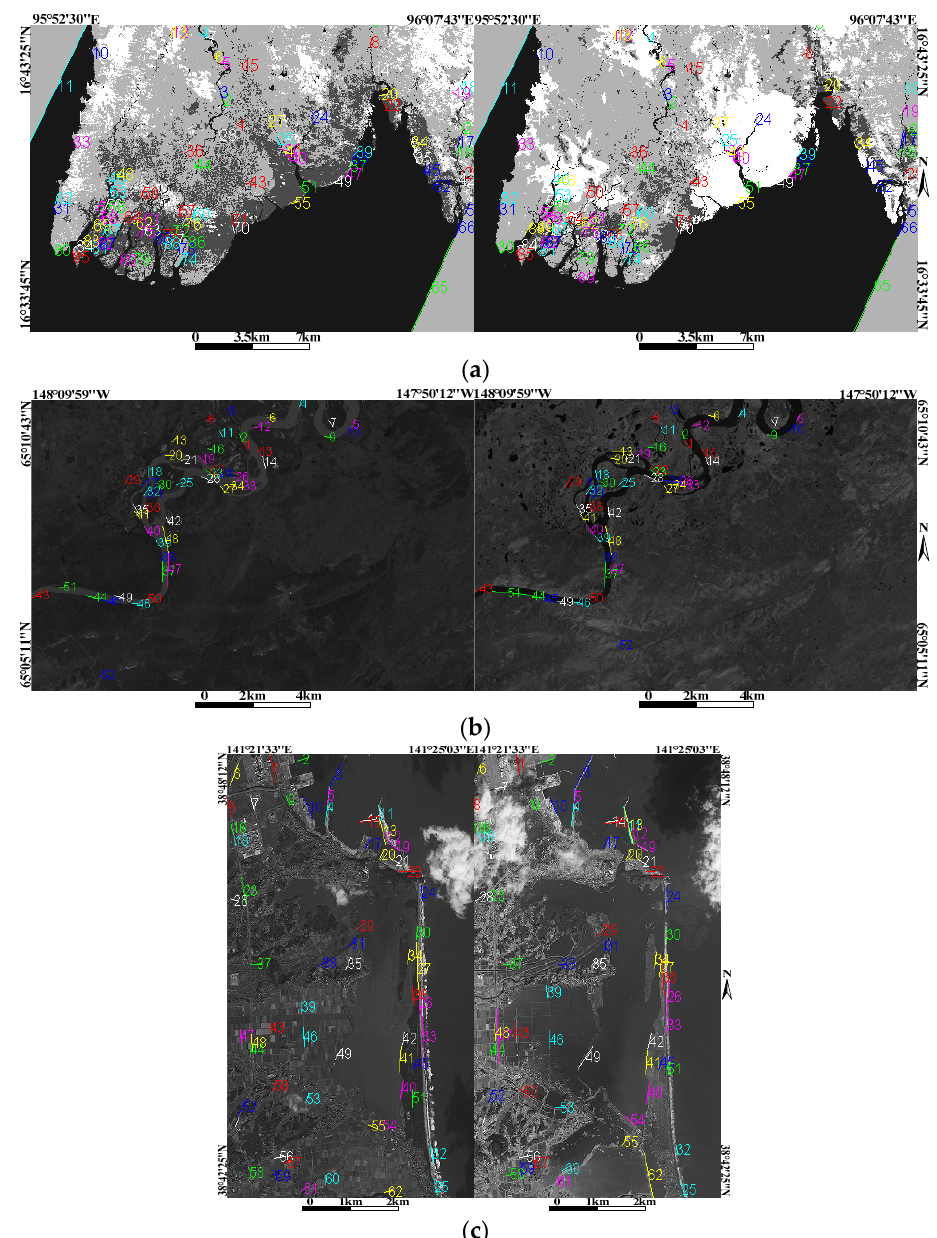
Figure 14. Matching results of the RMLSM on the medium- and low-resolution real image pairs. ( a ) The fifth image pair in the second group: Aqua-Aqua; ( b ) the sixth image pair in the second group: Landsat7-Landsat7; ( c ) the seventh image pair in the second group: SPOT 4-SPOT 4.